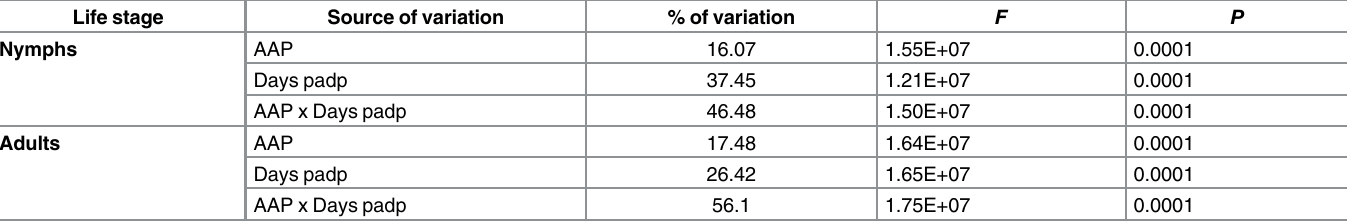
Table 4. ANOVA on the effects of acquisition access period (AAP), days post-first access to diseased plants (padp), and their interaction on Las titer (relative to RPS20 psyllid gene) following Las acquisition from infected citrus by D . citri nymphs or adults. Life stage